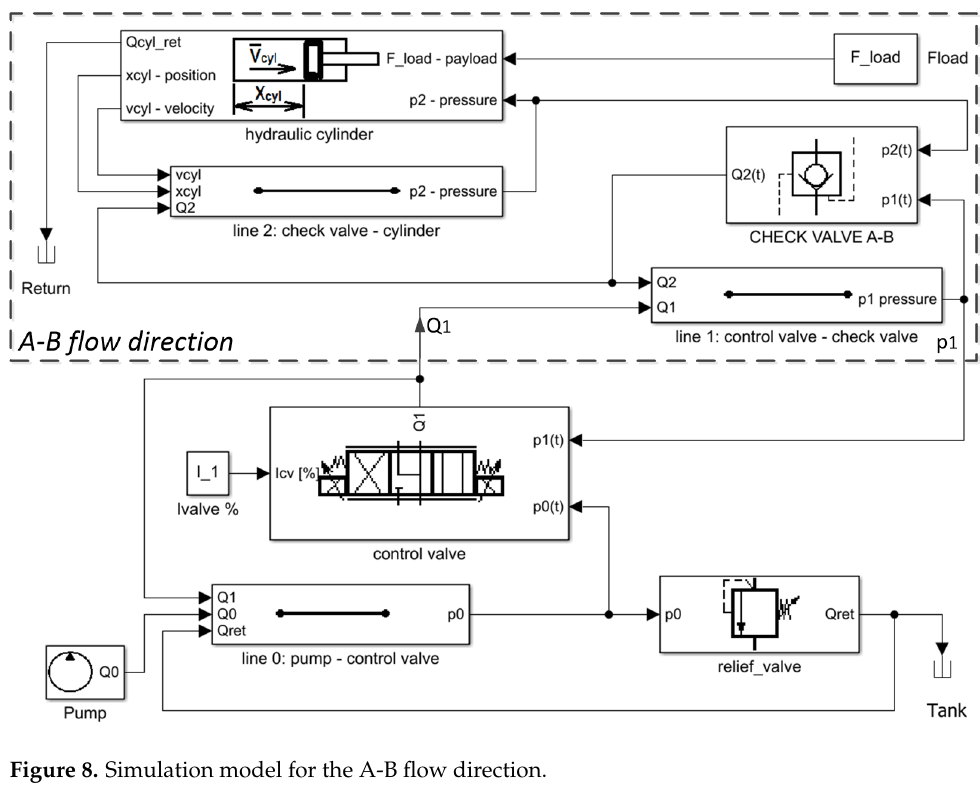
Figure 8. Simulation model for the A-B flow direction.